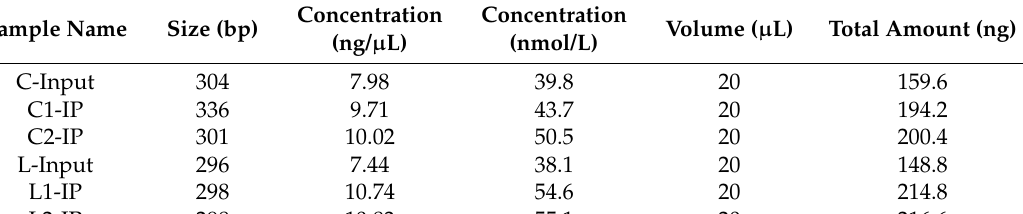
Table 4. Quality control (QC) of the ChIP experiment.